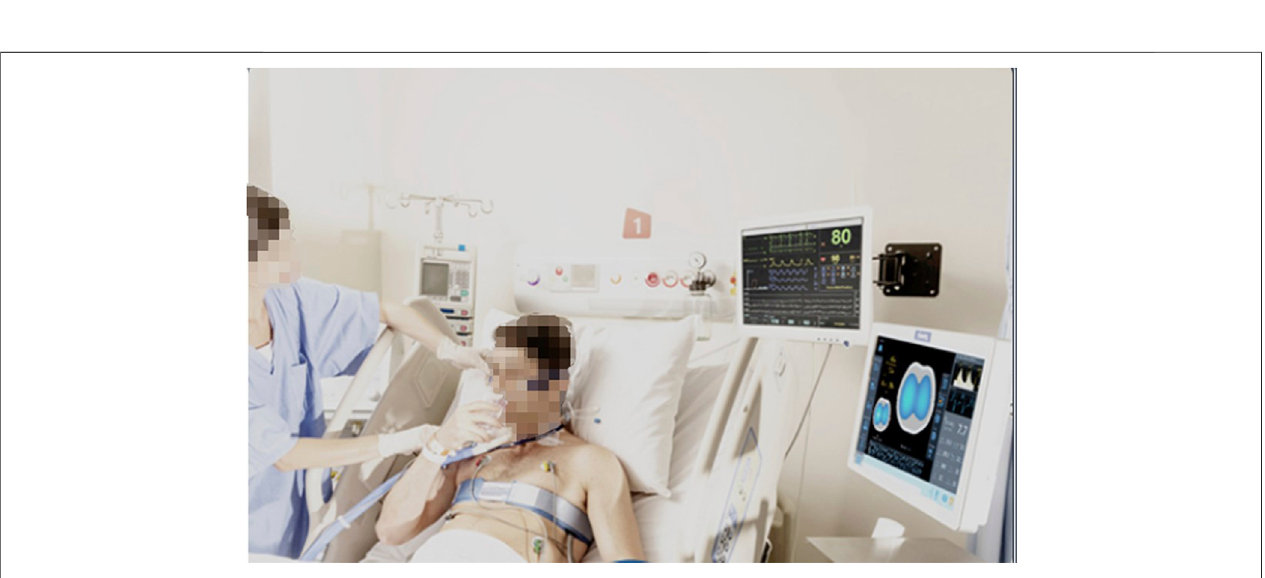
FIGURE 7 | The EIT device Enlight 1800 of Timper. Timper ’ s Enlight 1800 can monitor the patient ’ s lungs in real time, complete functional imaging and lung ventilation monitoring.